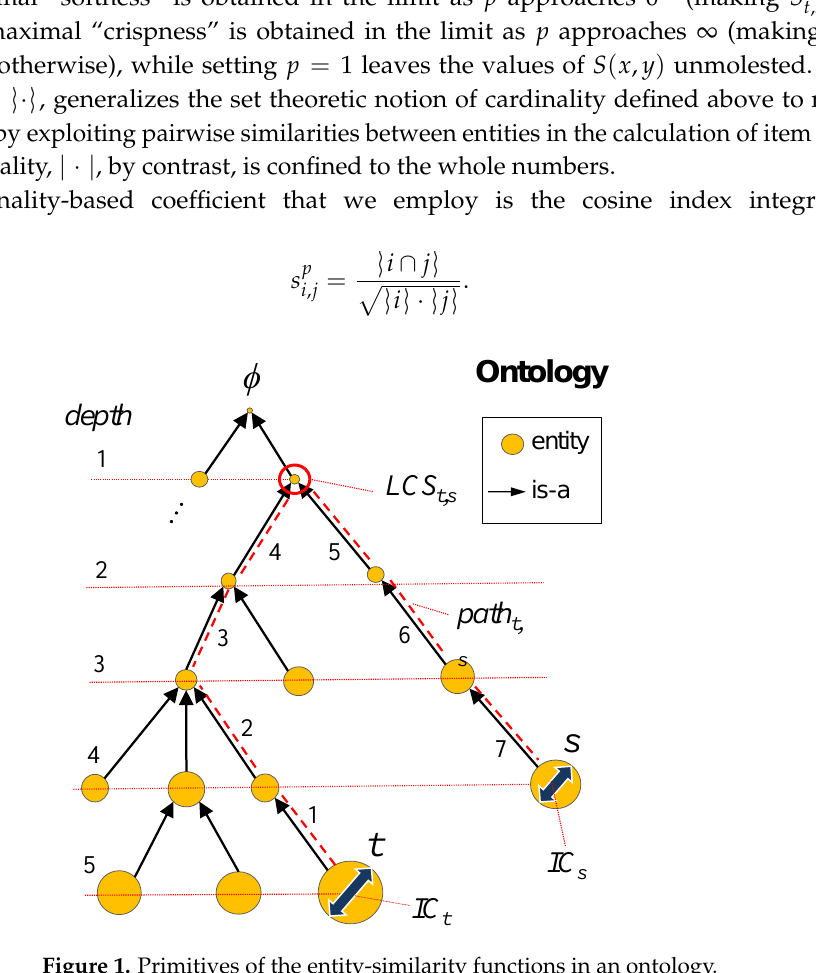
Figure 1. Primitives of the entity-similarity functions in an